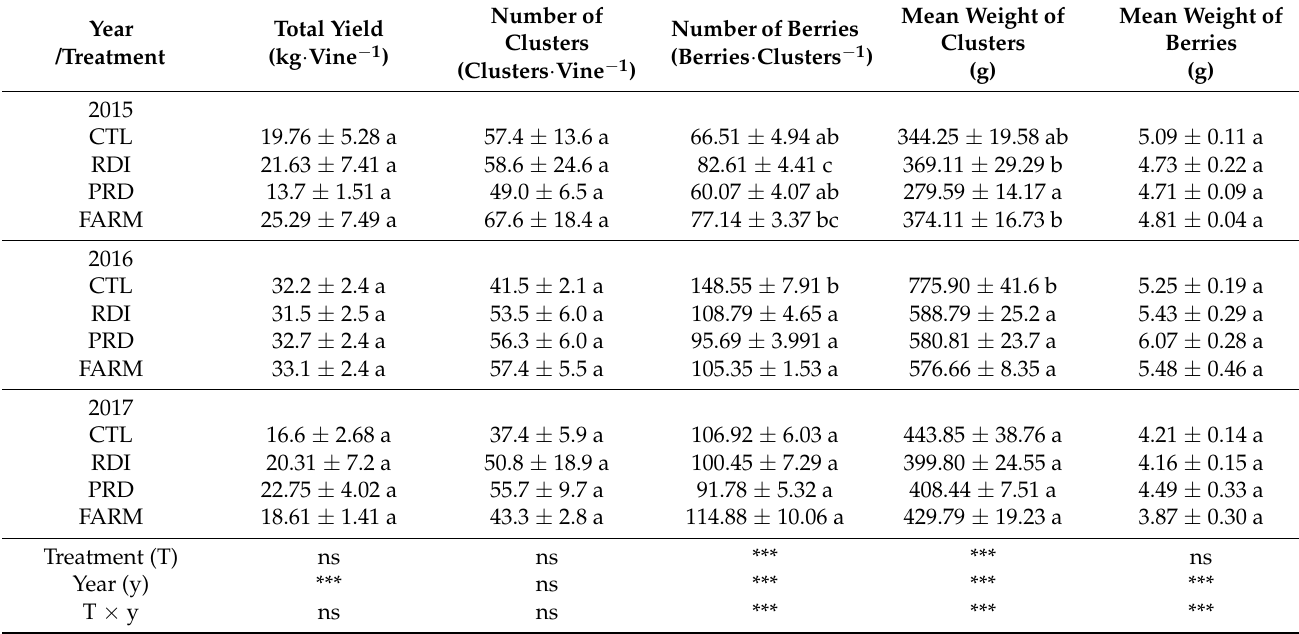
Table 1. Mean values of total yield per vine, number of clusters, mean weight of clusters, number of berries and mean weight of berries evaluated at harvest during the three years assayed (2015–2017), for all the irrigation treatments: Control, RDI, PRD and FARM. Values are means ± SE ( n = 15 vines per